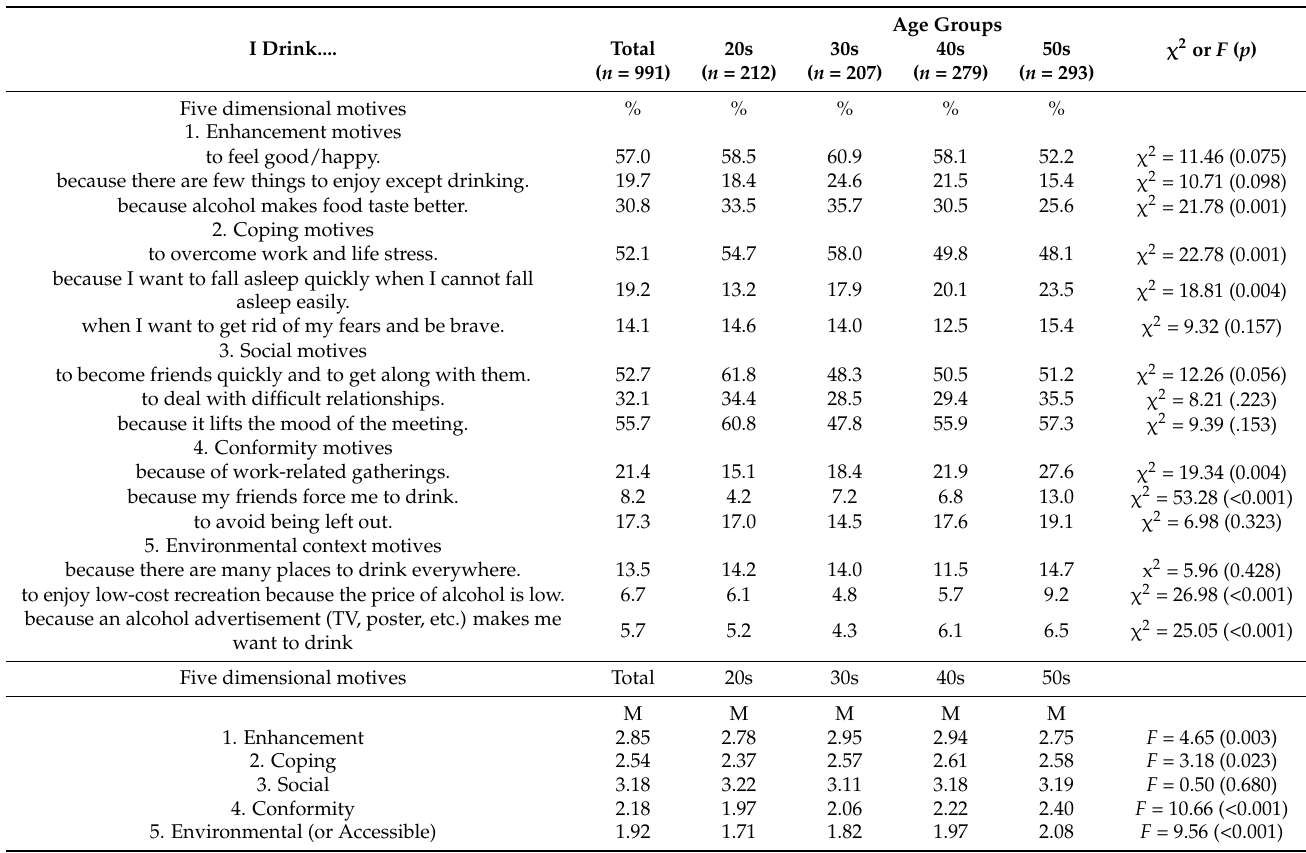
Table 3. Five drinking motives across age groups (% of agreement and mean; n = 991) †